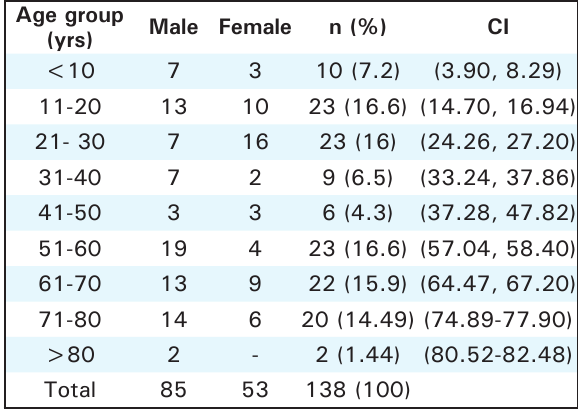
Table 1. Age wise distribution of pancytopenia cases.